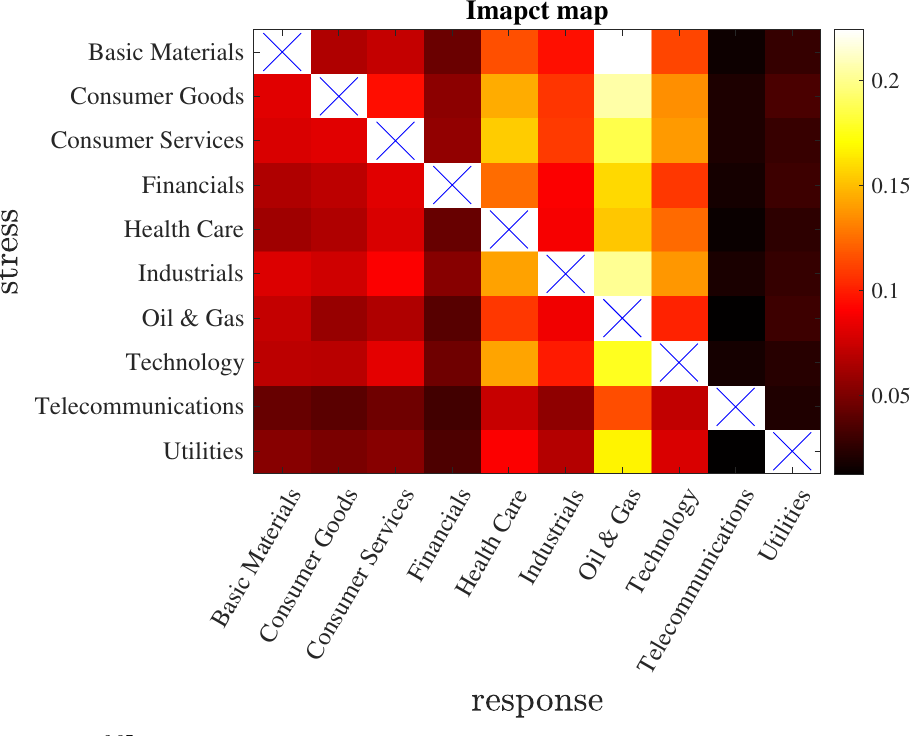
Figure 2. L 0.95 : average losses in a sector as consequence of conditioning another sector. The color X → Y map corresponds to the average amount of losses (negative log-returns) on a the sector reported on the columns (conditioned variables) caused by stressing at 95% VaR the sector reported on the rows (conditioning